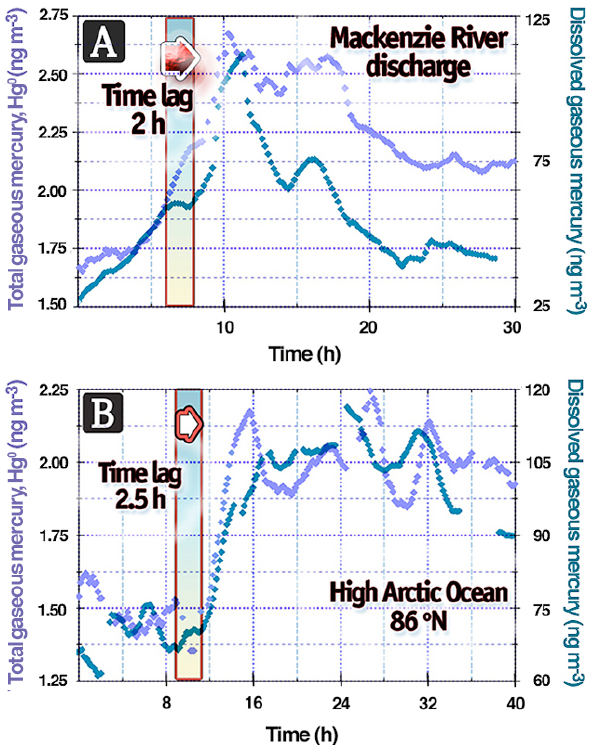
Figure 11 . The temporal air-sea distribution of Hg 0 vapour for two specific destinations: a. Mackenzie River discharge and b. high Arctic Ocean (~86 °N). Cross-correlation analysis Fig. 11. The temporal air-sea distribution of Hg 0 vapour for two revealed a maximised TGM, Hg 0 -DGM covariance for time lags of 2 h and 2.5 h, respectively. specific destinations: (a) Mackenzie River discharge and (b) high Thus, the time-series of TGM, Hg 0 and DGM has been shifted in a. by 2 h and in b. by 2.5 h. The maximum coefficient of correlation is 0.59 (n = 188) in case a and 0.54 (n = 307) in case b. Arctic Ocean ( ∼ 86 ◦ N). Cross-correlation analysis revealed a max- The distribution of Hg 0 between air and sea is in both cases in strong disequilibrium. imised TGM, Hg 0 -DGM covariance for time lags of 2 h and 2.5 h, respectively. Thus, the time-series of TGM, Hg 0 and DGM has been shifted in (a) by 2 h and in (b) by 2.5 h. The maximum coefficient of correlation is 0.59 ( n = 188) in case a and 0.54 ( n = 307) in case b. The distribution of Hg 0 between air and sea is in both cases in strong